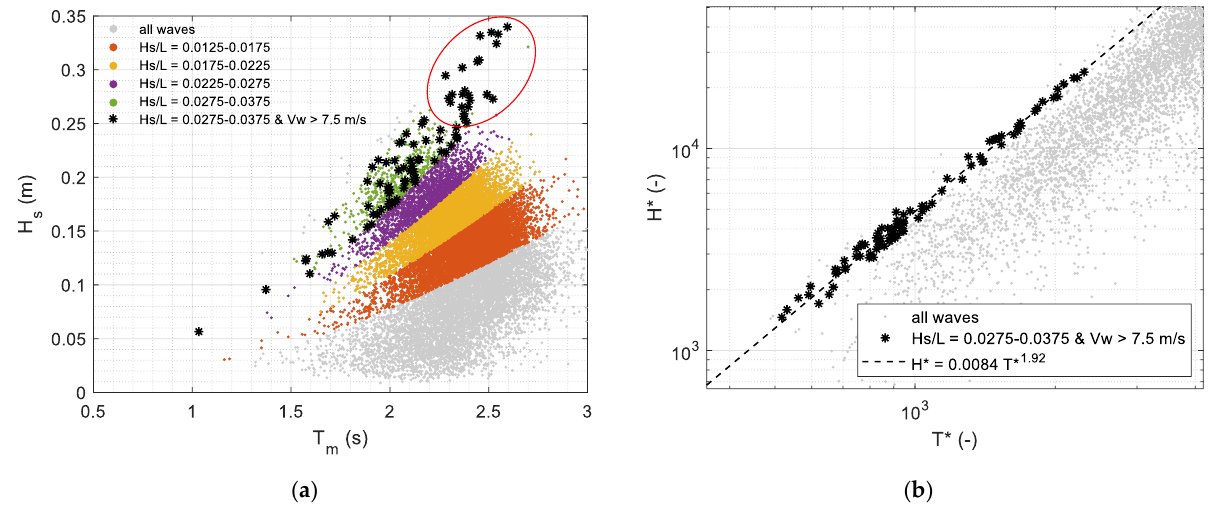
Figure 4. ( a ) H S and T m dependency: some points are highlighted based on their wave steepness, the black stars highlight the wind-generated waves and the red ellipse indicates the waves with H S larger than 0.25 m, i.e., those generated by stormy events ( V w is the simultaneous wind velocity). ( b ) Similarity in wind waves between dimensionless significant wave height H * and dimensionless wave period T *; the same subset of black stars are highlighted.